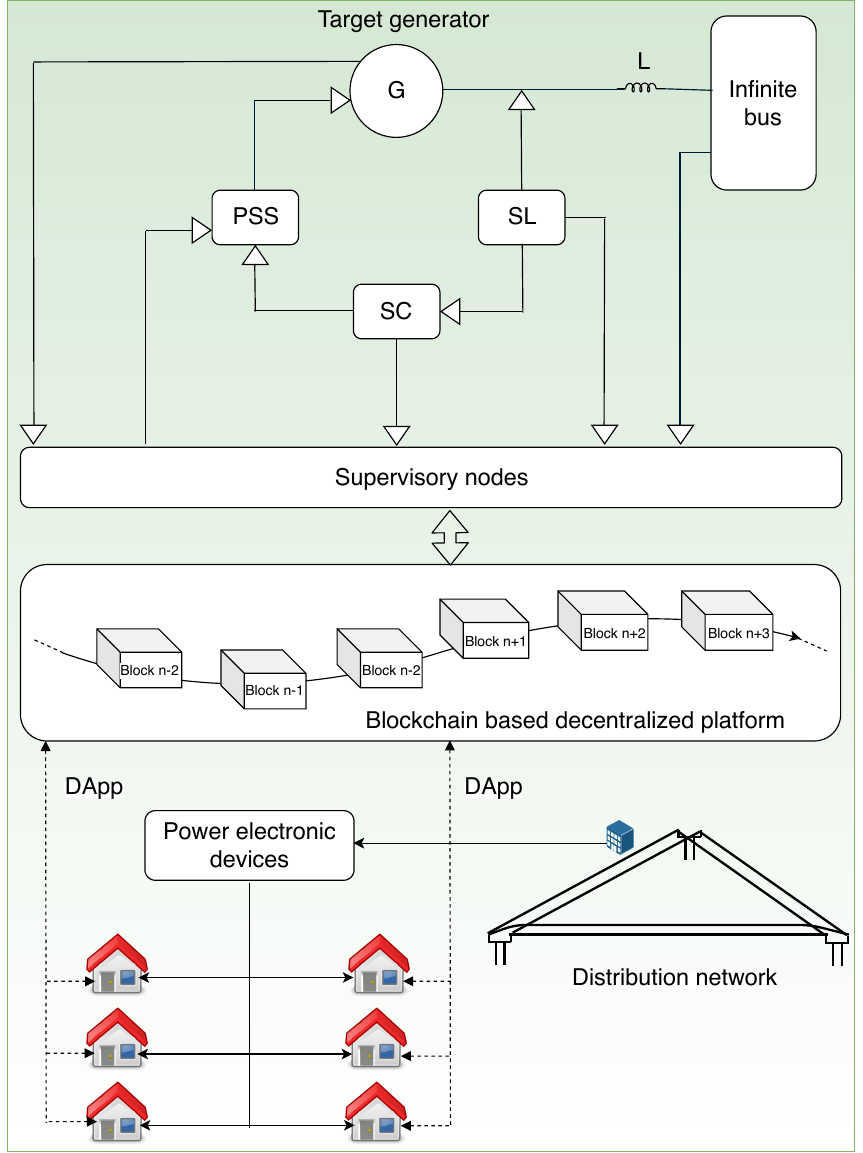
Figure 9. Architecture for power generation and